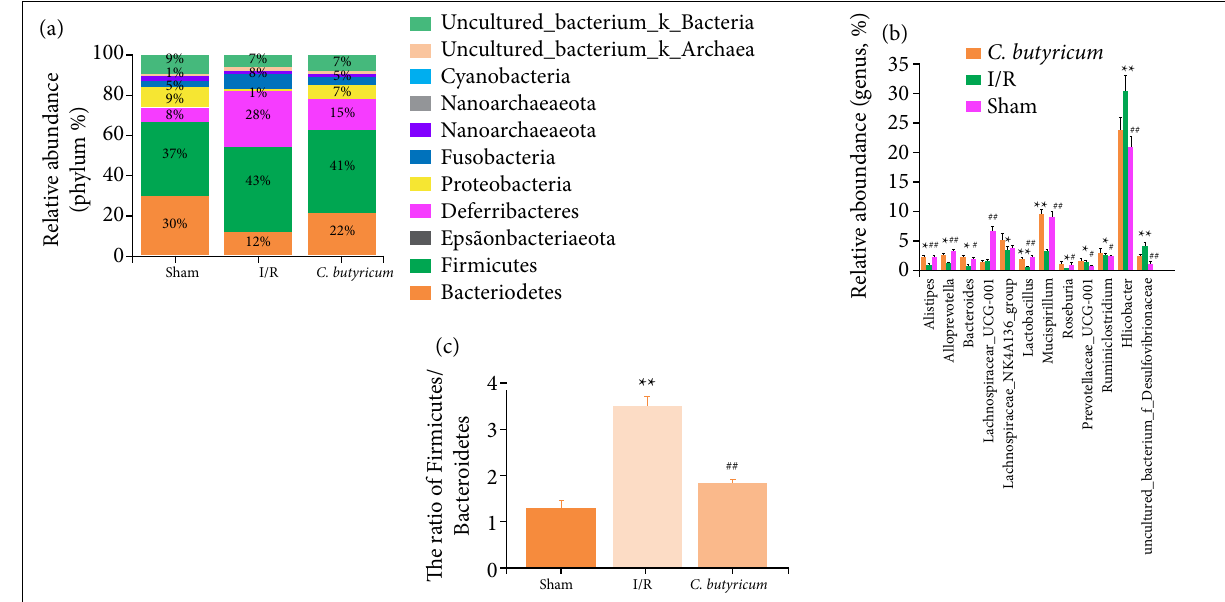
Figure 7 - The effects of C. butyricum dietary supplement on the microbial composition in (a) the feces at the phylum, (b) genus levels, and the ratio of (c) Firmicutes/Bacteroidetes after reperfusion for